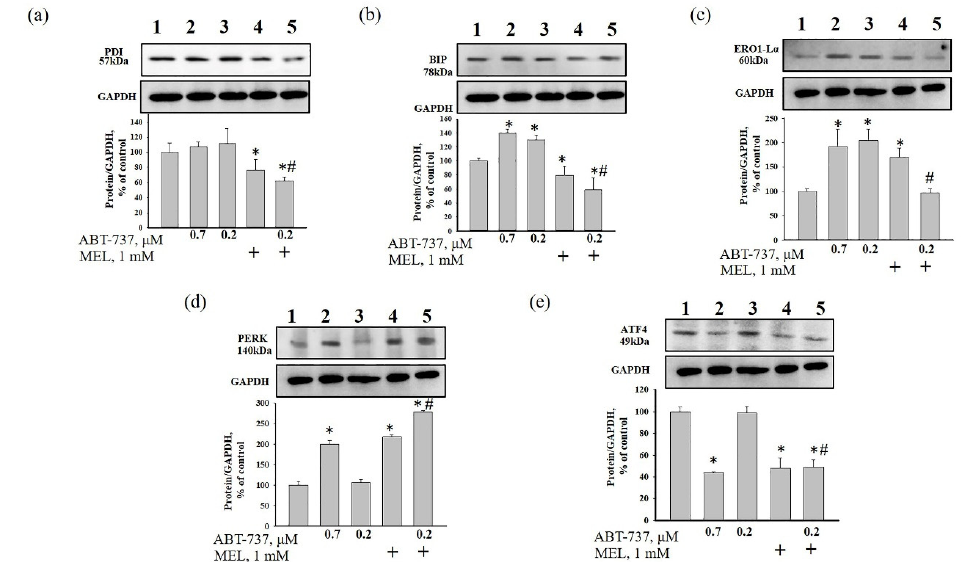
Figure 6. The c ombined effect of MEL and ABT-737 on the level of ER stress markers—Protein disulfide isomerase (PDI) ( a ), binding immunoglobulin protein (BIP) ( b ) ER oxidoreductin 1-L α (ERO1-L α ) ( c ), protein kinase R (PKR)-like endoplasmic reticulum kinase (PERK) ( d ) and the activating transcription factor ATF4 ( e ) in HL-60 cells. Cells were treated with 0.7 µ M ABT-737 (column 2), and 0.2 µ M ABT-737 (columns 3) and 1 mM MEL (column 4), and MEL in combination with 0.2 μ M ABT-737 (column 5); untreated cells (control, column 1). The ratio of protein levels to GAPDH was used as a loading control. The protein level in the cell lysate without any additives served as a control (100%). “+” means the presence of MEL The data are presented as the means ± S.D. of three separate experiments. * p < 0.05 significant di ff erence in the protein level relative to the control (untreated cells), # p < 0.05 significant di ff erence in the protein level compared to ABT-737 alone (0.2 µ M, column